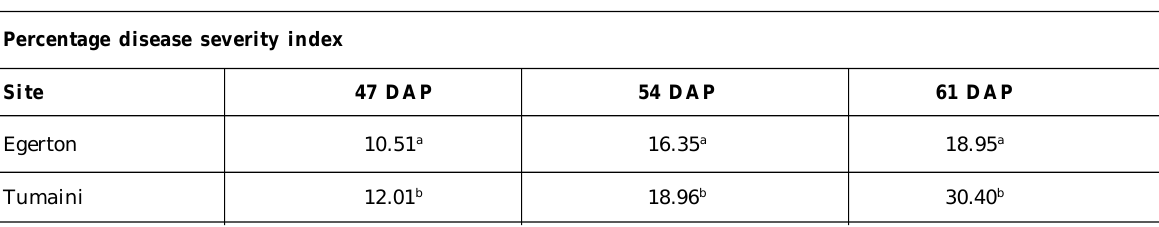
Table 1: Effects of experimental sites on P. infestans severity on potatoes crop Percentage disease severity